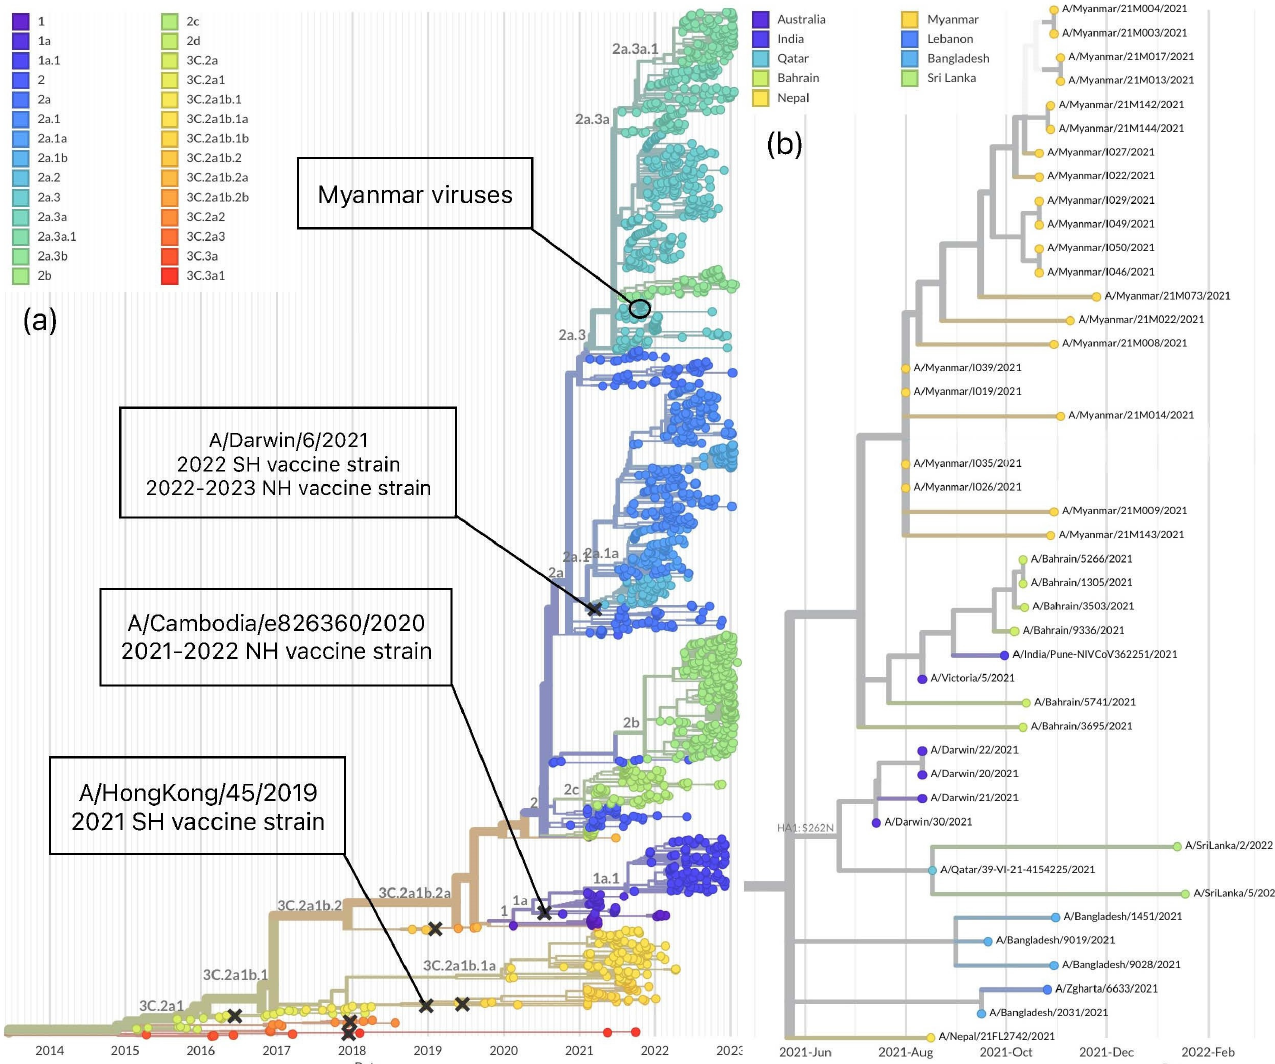
Figure 2. Time ‐ aware phylogeny of the HA segment of the influenza A(H3N2) viruses constructed by Nextstrain (accessed on 17 February 2023) [27]. ( a ) Clade differentiation of the globally circulated influenza A(H3N2) based on the HA segment. The vast majority of circulated viruses worldwide and Myanmar viruses in 2021, are categorized under clade 2, circulation of three different clades were observed: 3C.2a1b.1a, 1 and 1a. Vaccine strains for SH 2021 belonged to clade 3C.2a1b.1b and those for NH 2021–2022 to the clade 1a. Newly selected vaccine candidate for SH 2022 and NH 2022–2023 seasons belongs to the clade 2a. ( b ) Close look at the Nextstrain phylogeny including influenza A(H3N2) viruses in Myanmar and genetically similar viruses in other countries during 2021 and 2022. Strains, collected in Myanmar in 2021 are similar to those found in Bahrain, Australia, Qatar, Sri Lanka, Bangladesh, and Nepal.